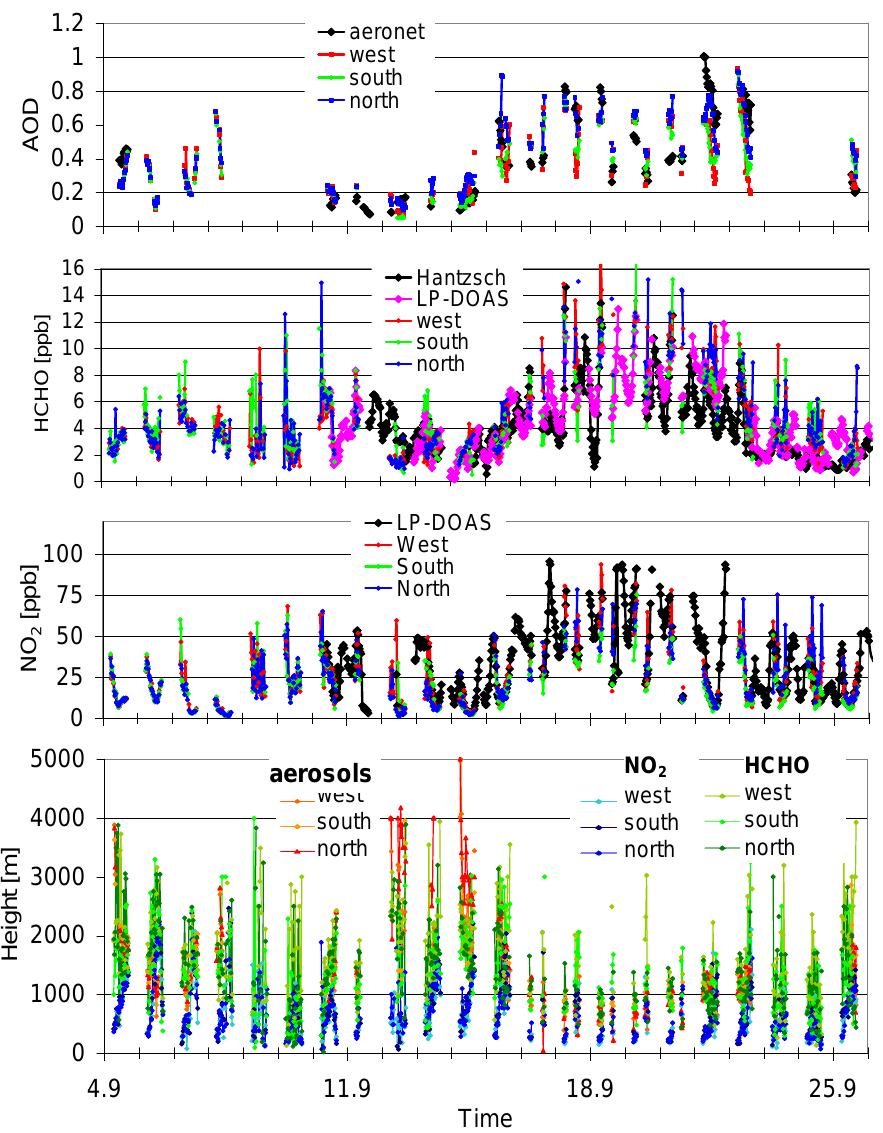
Fig. 16 Half hour averages of the AOD, mixing ratios of NO 2 and HCHO and layer heights for the whole campaign. Also the results for the LP-DOAS and Hantzsch instrument and the AERONET AOD (at Ispra) are shown for comparison. Only measurements are shown, for which the differences between the measurements and the forward model are small ( χ 2 > 0.05). Also periods with large horizontal gradients were skipped (see text). In addition, aerosol results for which the AOD varies more than 0.5 between successive measurements were also discarded.